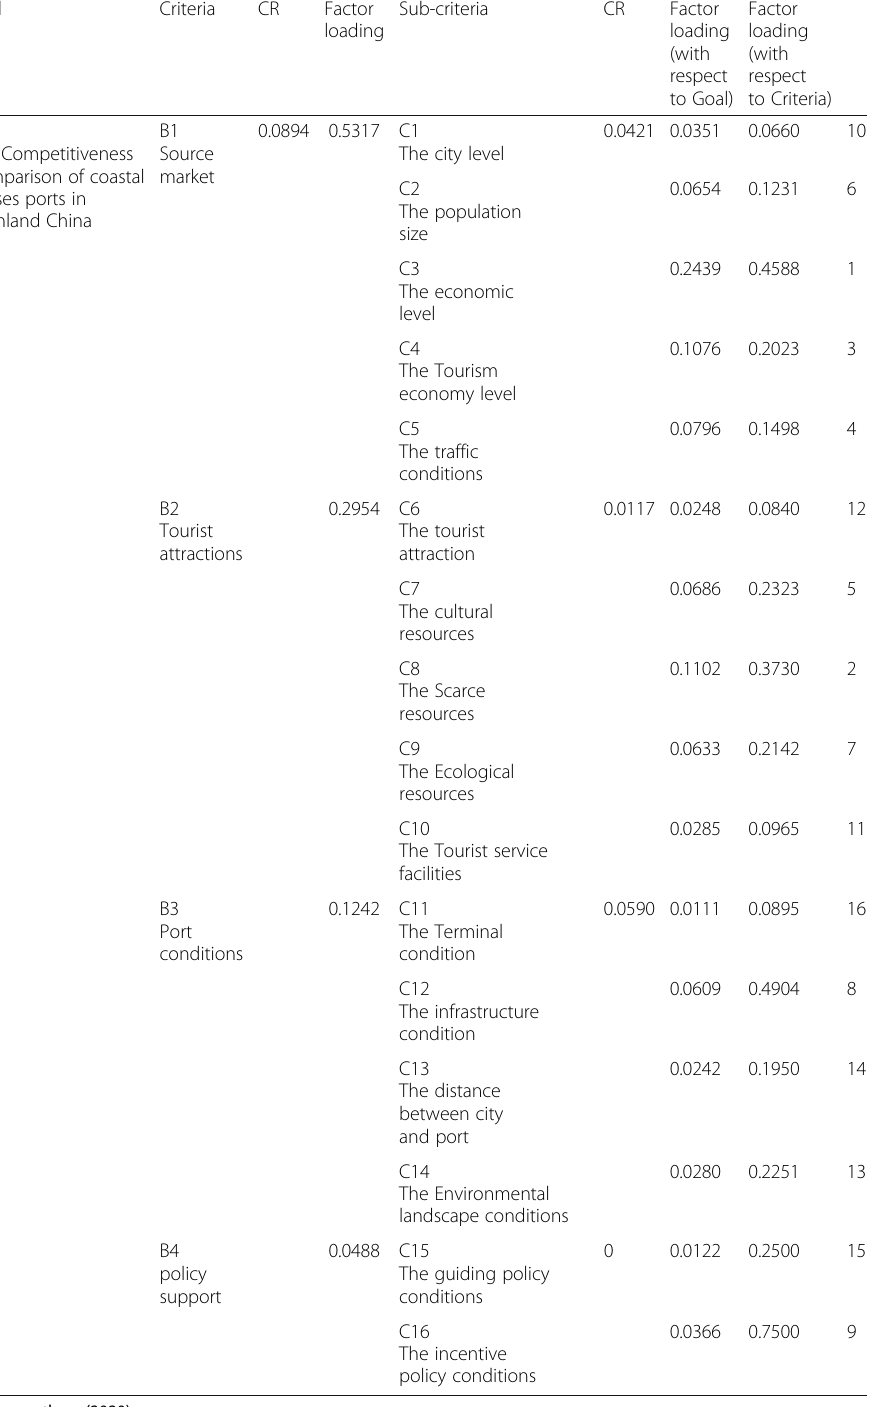
Table 8 The AHP results Goal Criteria CR